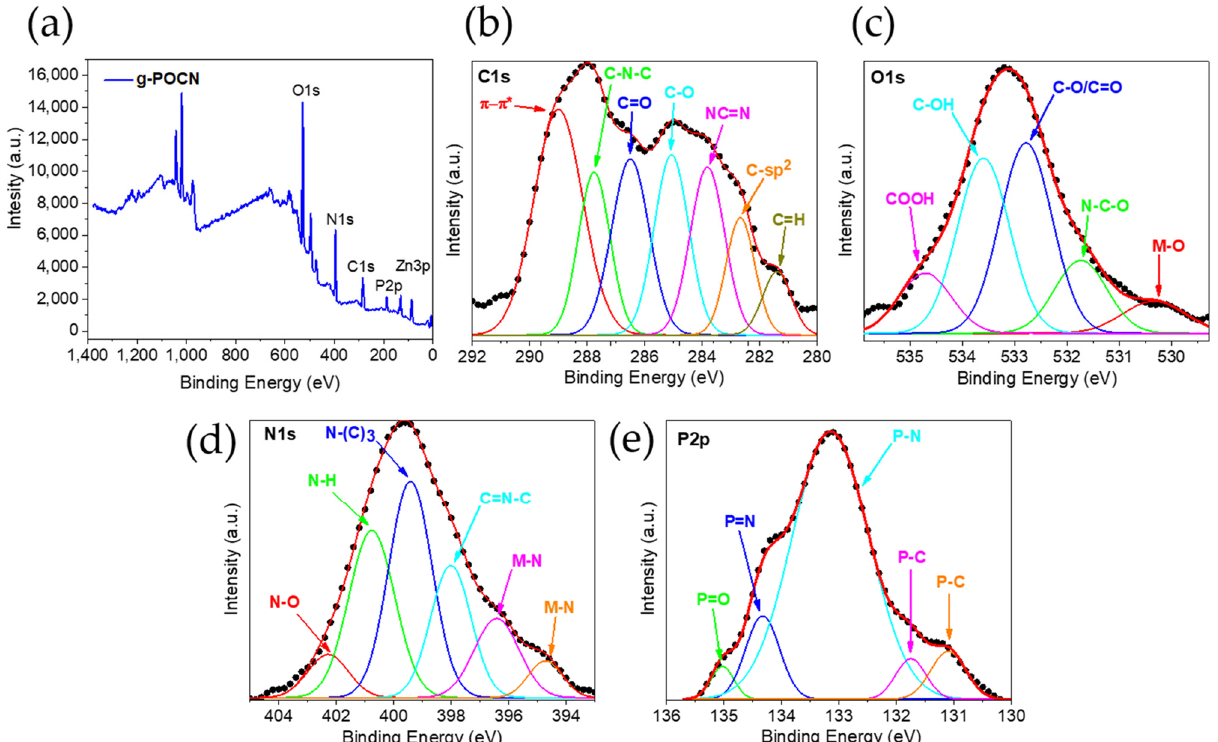
Figure 3. ( a ) XPS survey spectra of g-POCN, peak-fitted high-resolution ( b ) C1s, ( c ) O1s, ( d ) N1s, ( e ) P2p XPS spectra of g-POCN.